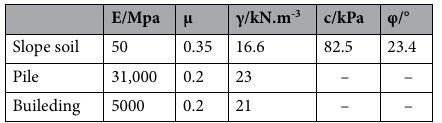
Table 3. Material